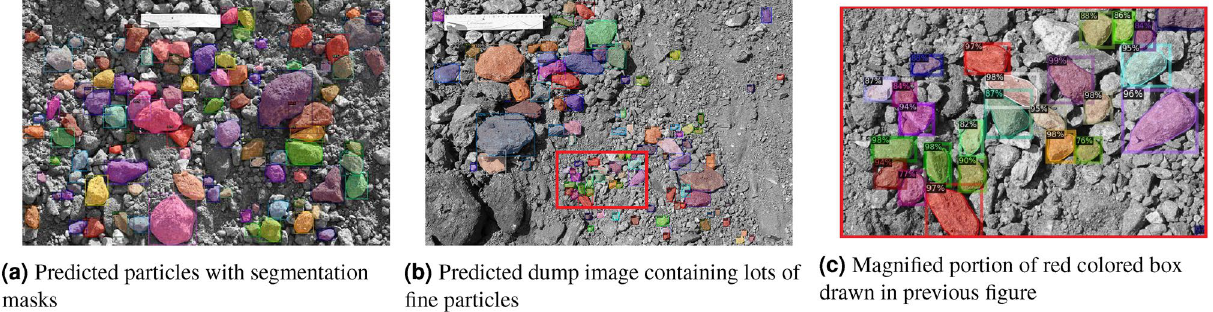
Figure 5. Inferences from the Mask R CNN with backbone network on ResNet50 plus an FPN